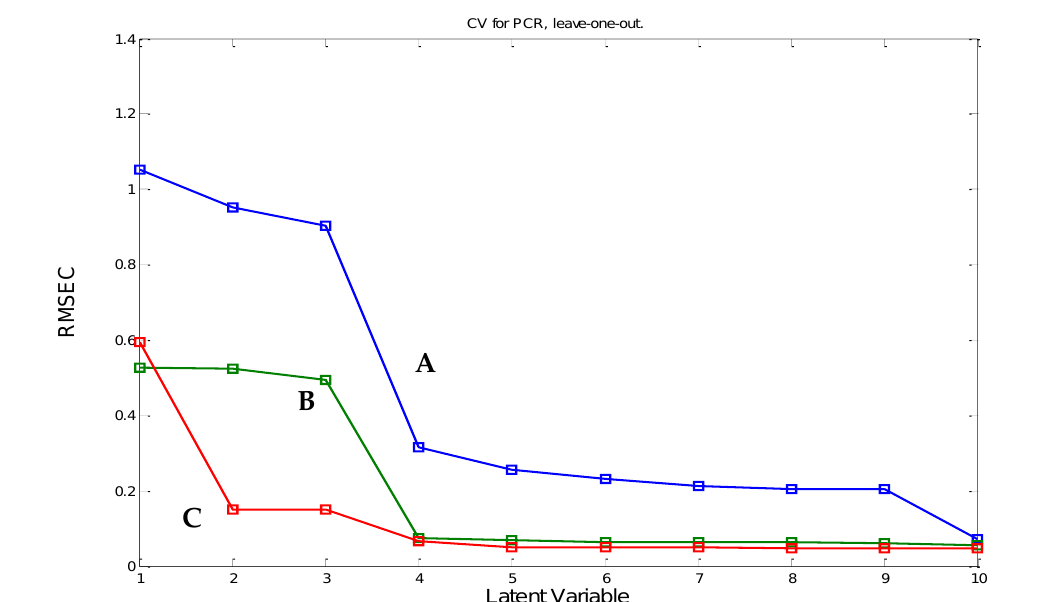
Table 1. The genetic algorithm